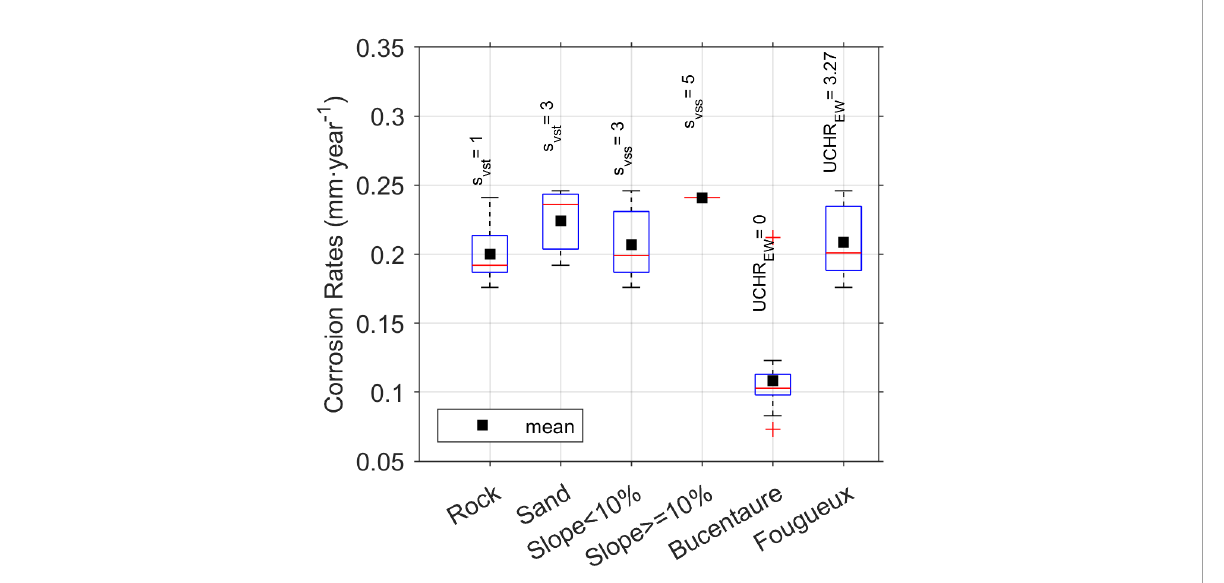
FIGURE 10 Box plot of corrosion rates by group according to the environment factor (vulnerability index assessment at the Fougueux site) and location (erosive wear risk at the Fougueux and Bucentaure